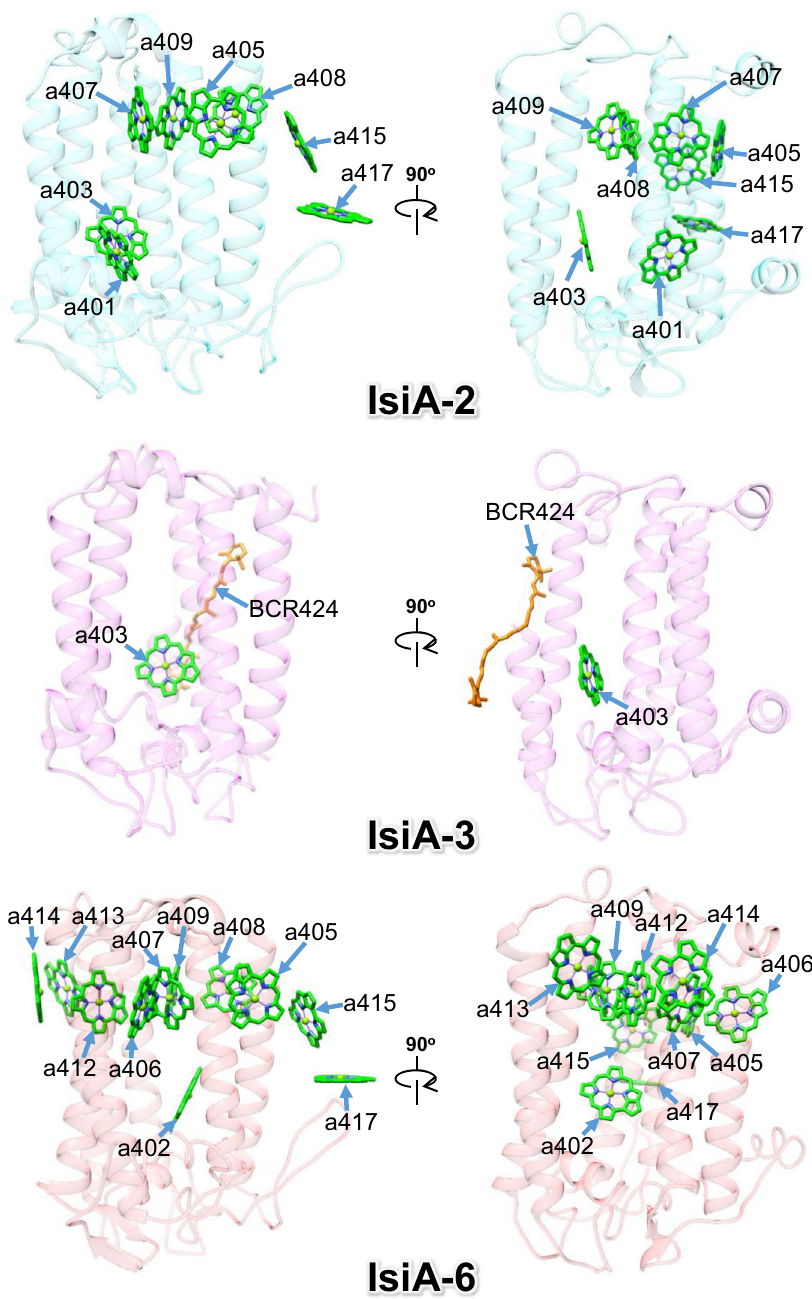
Fig.4|StructuresofIsiA-2,IsiA-3,andIsiA-6. StructuresofIsiA-2,IsiA-3,andIsiA- 6 depicted in transparent cartoon model and arrangements of Chl and β -carotene